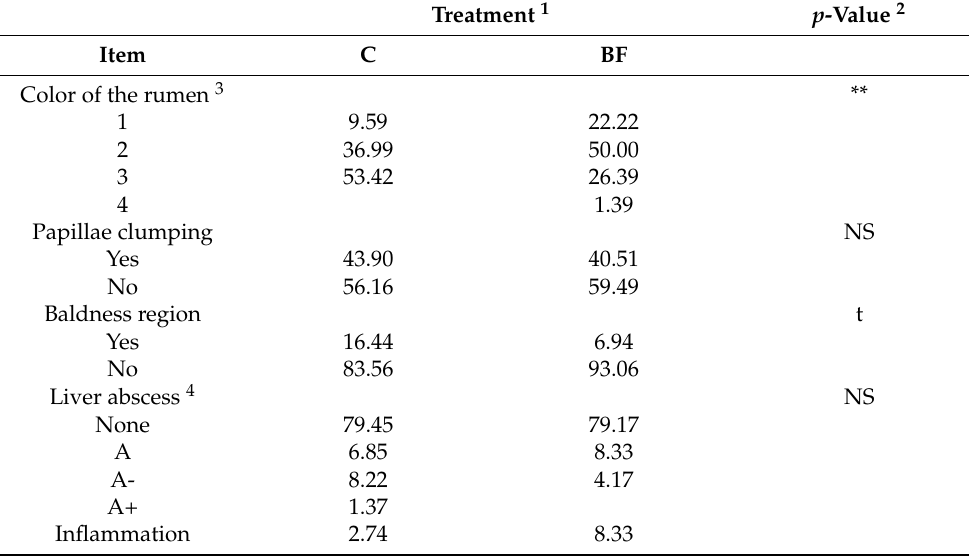
Table 6. Macroscopical observations of the rumen and liver at the slaughterhouse of Holstein bulls fed high-concentrate diets supplemented with citrus flavonoids. Treatment 1 p -Value 2 Item C